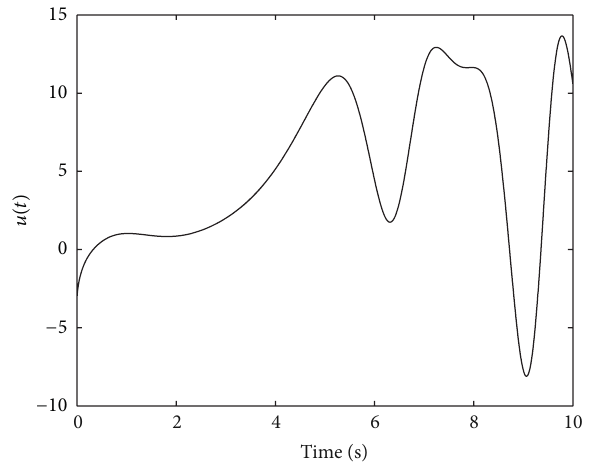
Figure 8: Time history of the control input